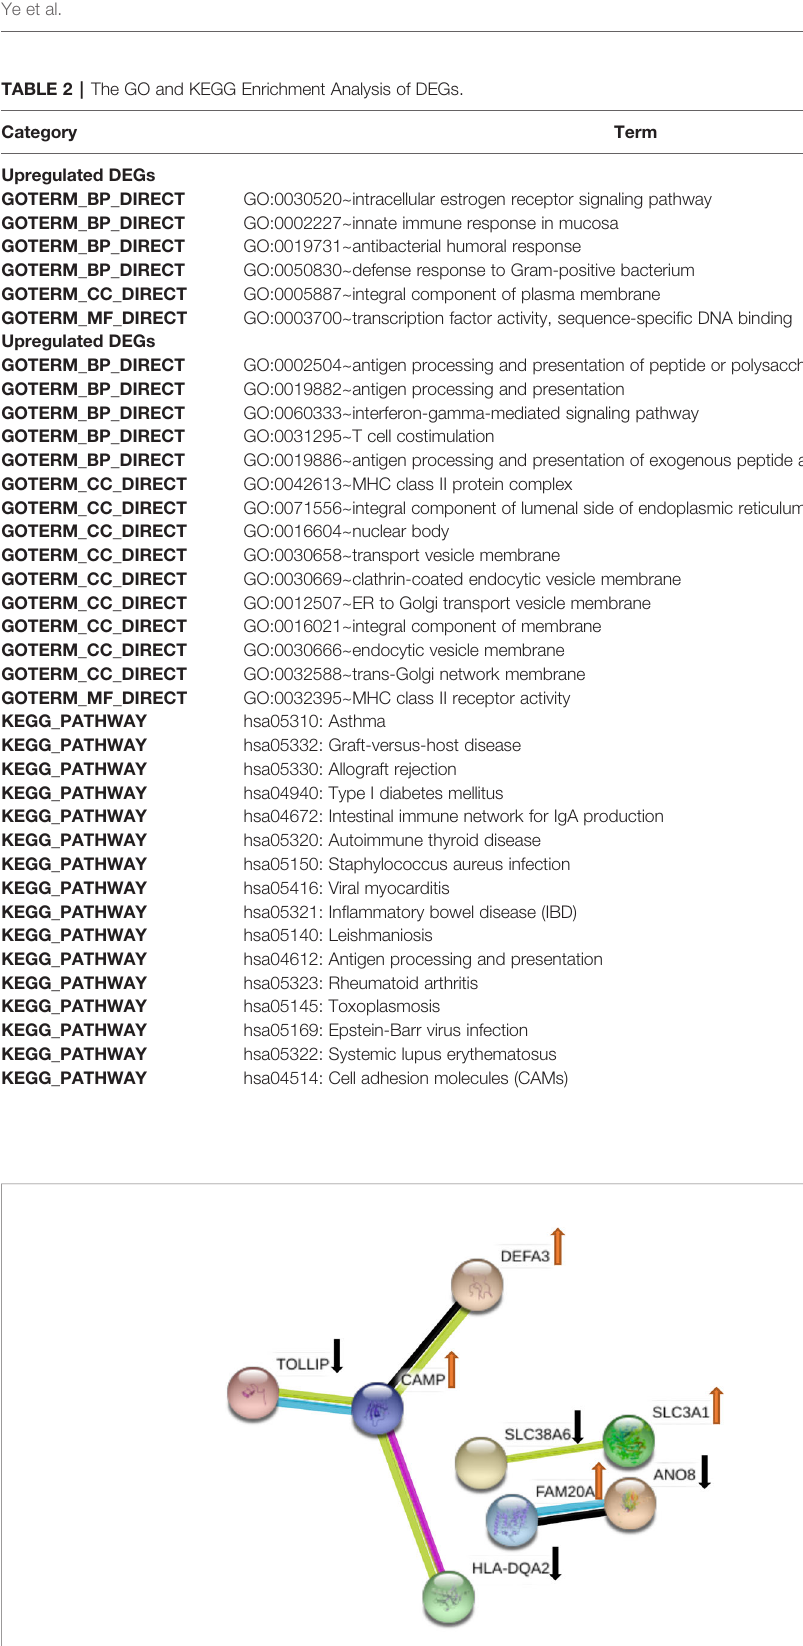
FIGURE 5 | PPI networks of DEGs. Sixty-six genes were clari fi ed into the PPI network using the STRING databank. ↑ indicates up-Genes; ↓ indicates